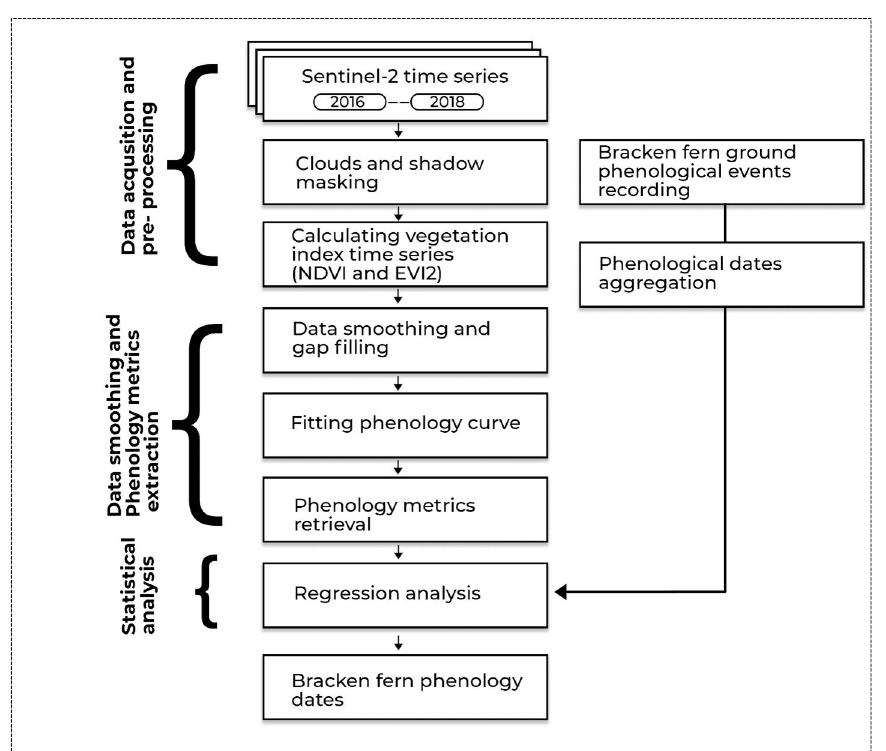
Fig 3. Schematic diagram illustrating the research methodology adopted in this